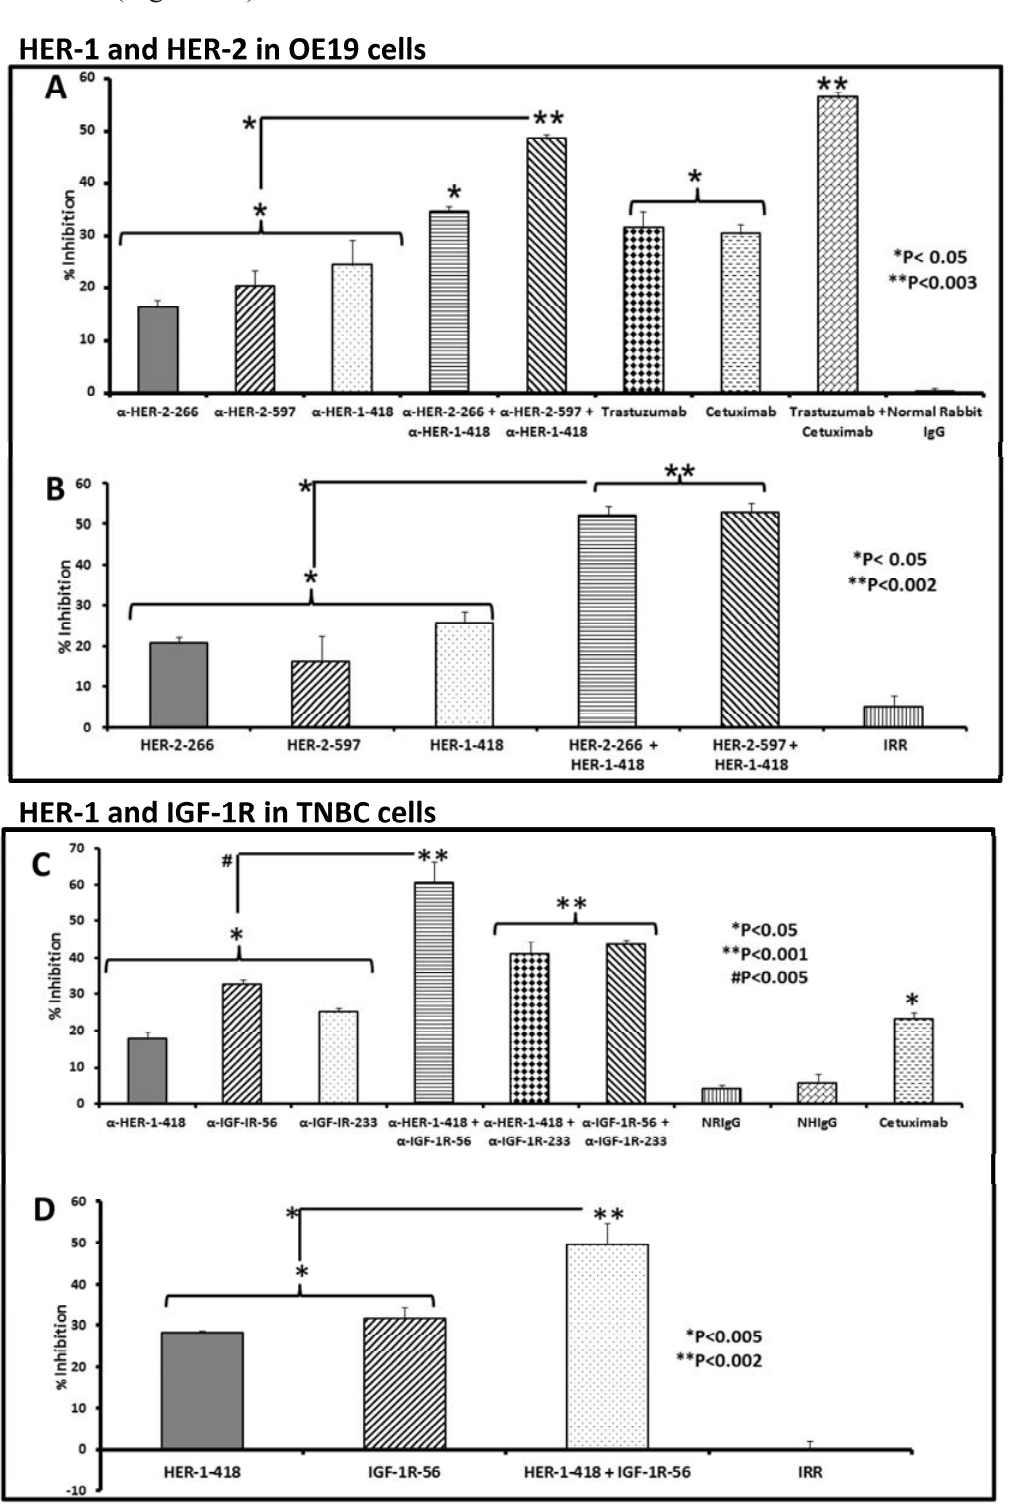
Figure 1. Effects of co-targeting HER-1 and HER-2 in EC or HER-1 and IGF-1R in